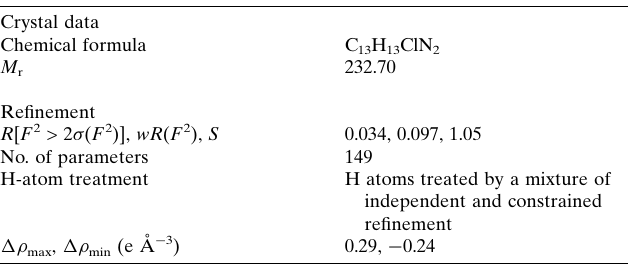
Table 2 Updated experimental details. Crystal data Chemical formula